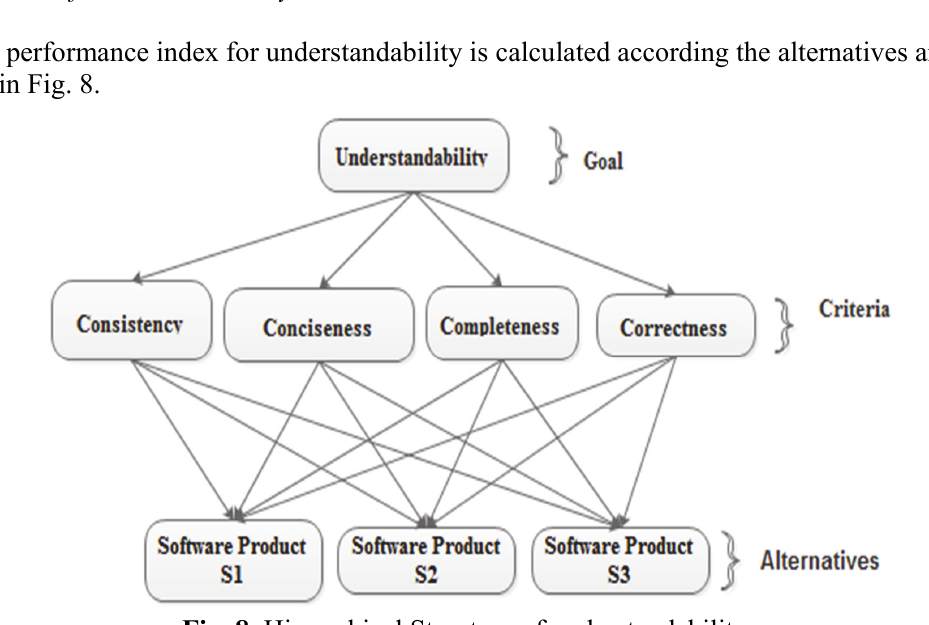
Fig. 8. Hierarchical Structure of